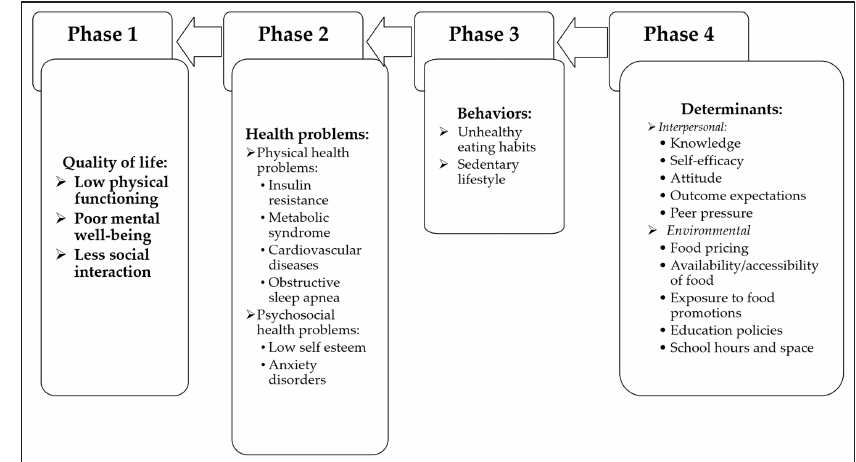
Figure 1 Representation of the logic model in IM-Step